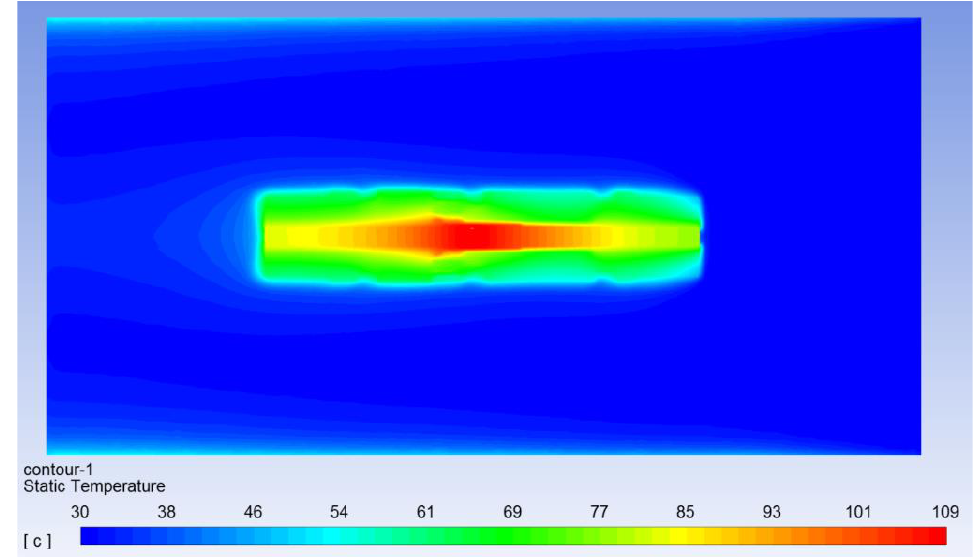
Figure 9. Temperature distribution around DC connector with current flow ( I = 13.22 A) — case 6 in Table 1. Max temperature: 109 °C.